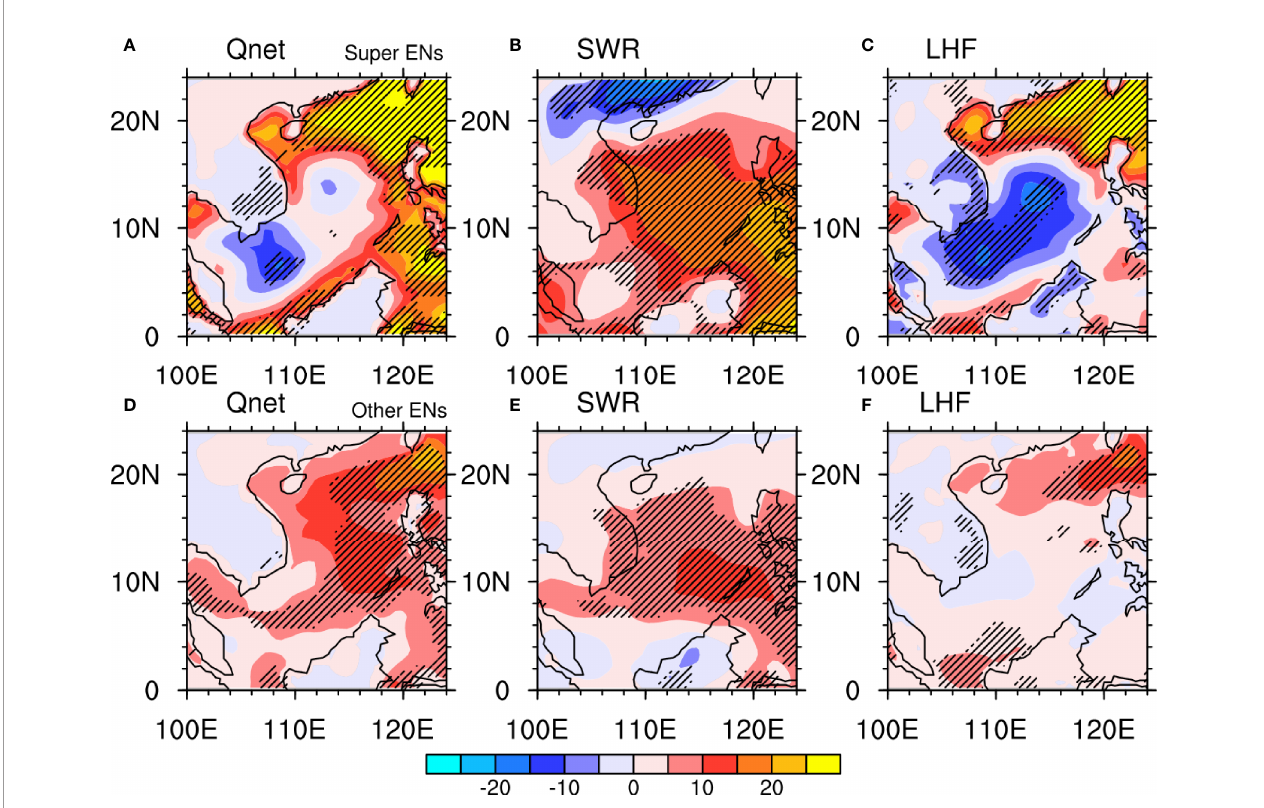
FIGURE 6 | (A) The Qnet anomalies, (B) SWR, and (C) LHF anomalies averaged over OND(0) for super El Niño composite (Unit: W/m 2 ). (D – F) Same as in (A – C) but for other El Niño composite. The composite results exceeding the 90% con fi dence level are hatched based on Student ’ s t